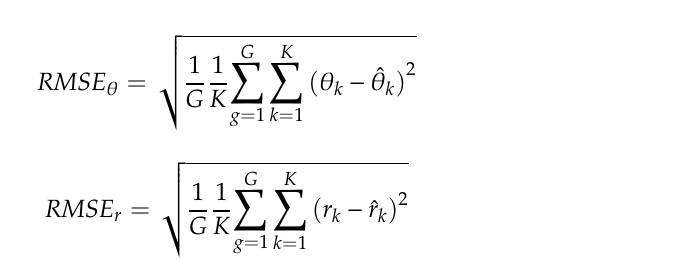
Figure 3. The range estimation results obtained by the proposed algorithm with unpairing and pairing. ( a ) Unpaired range estimation; ( b ) paired range estimation.